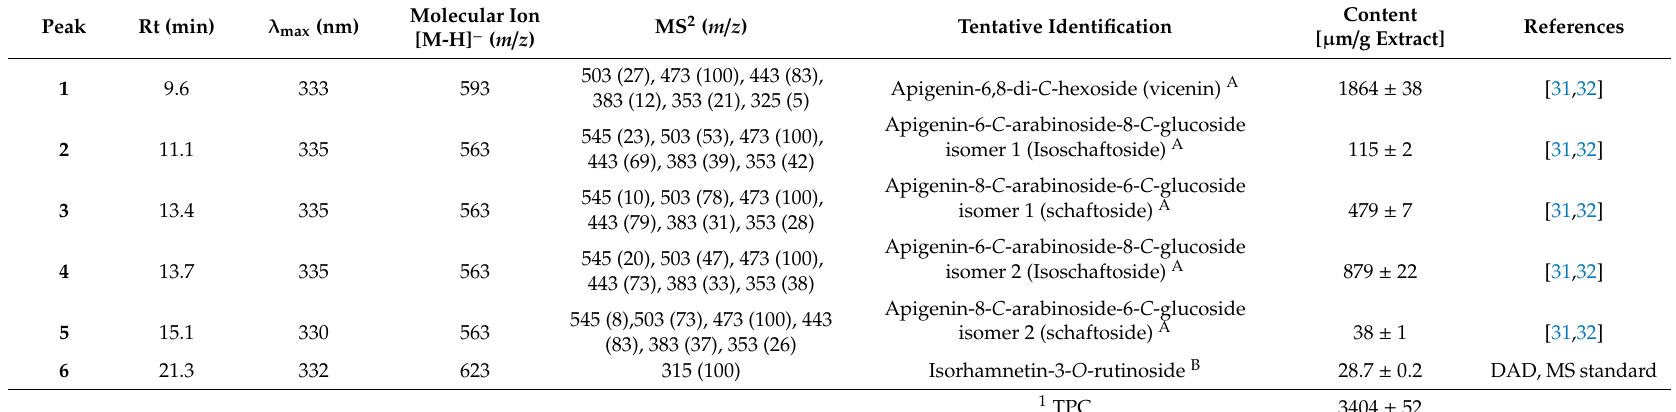
Table 2. Phenolic compounds quantification in Prosopis pallida flour derived from pod mesocarp (mean ±